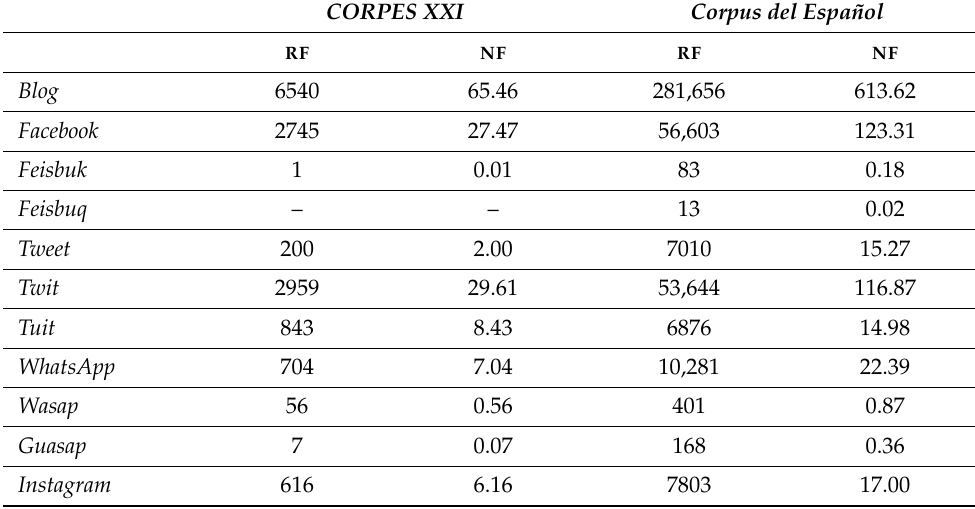
Table 2. Raw and normalized frequencies of the terms under analysis in the CORPES XXI corpus and Davies’s (2016) Corpus del